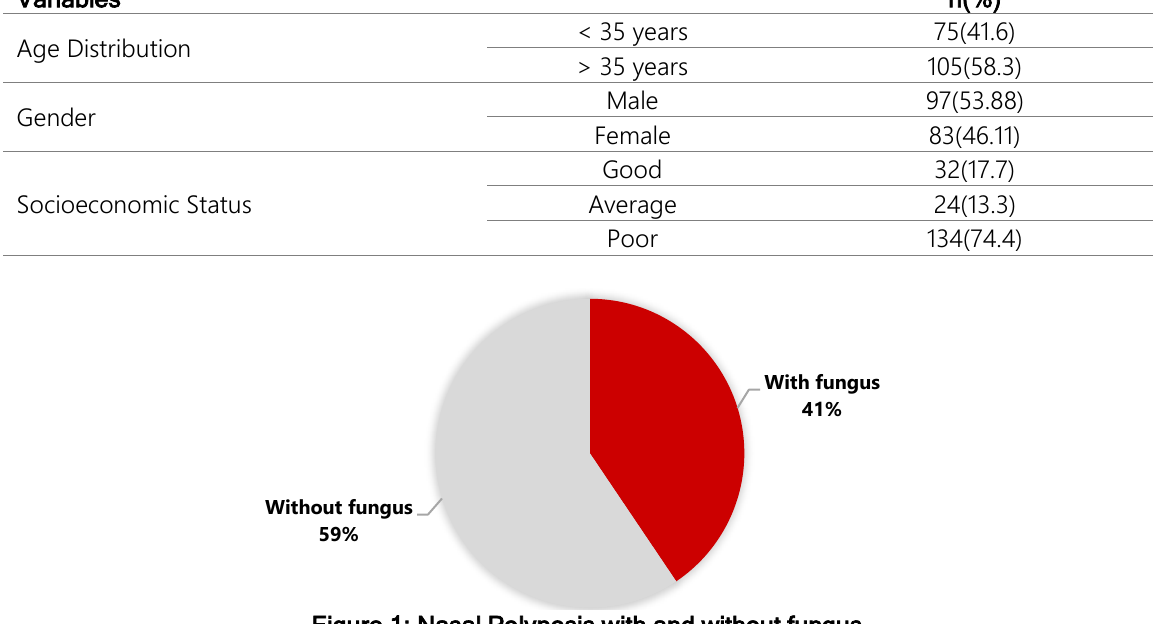
Figure 1: Nasal Polyposis with and without fungus